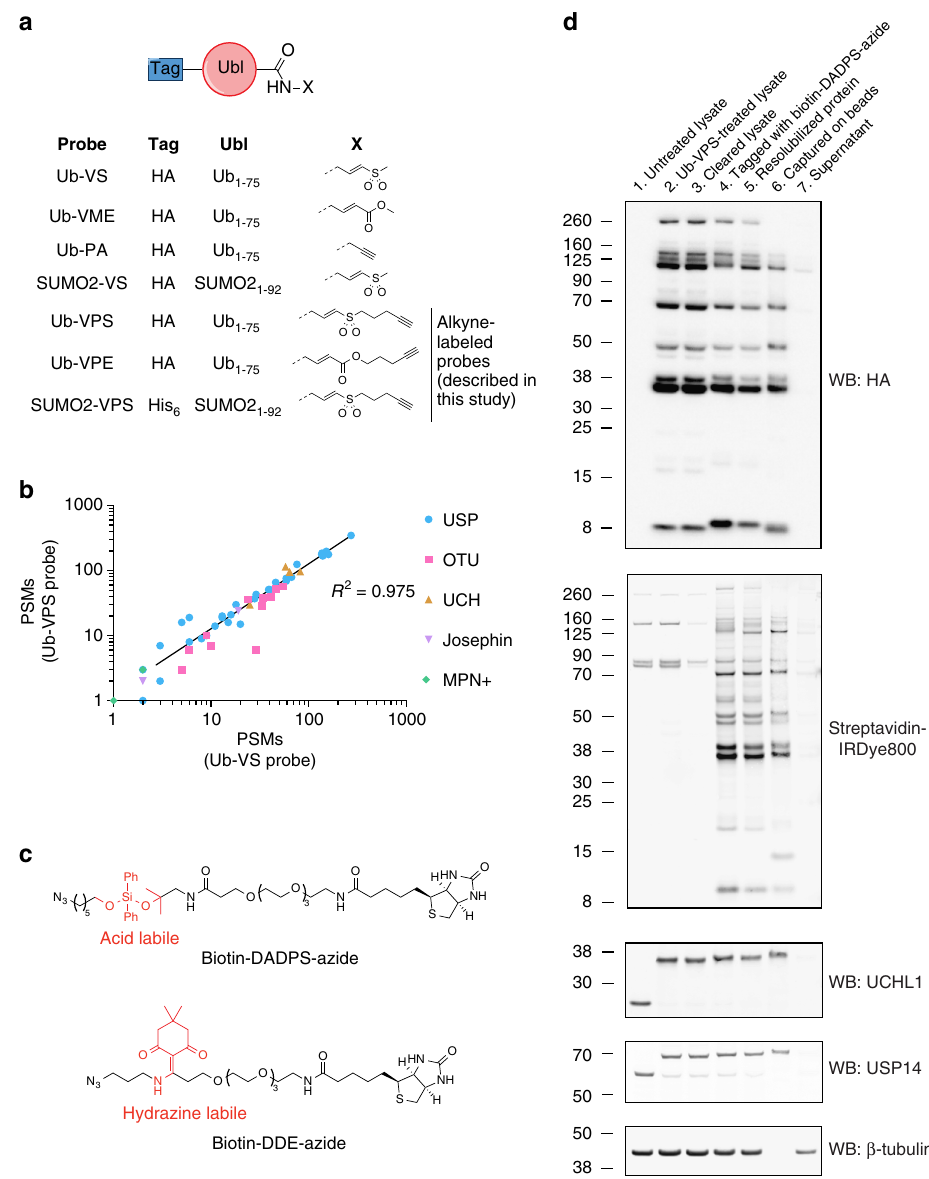
Fig. 2 Design and reactivity of alkyne-containing DUB probes. a Structures of probes used in this work. The vinyl pentynyl sulfone (VPS) and vinyl pentynyl ester (VPE) probes maintain the electrophilic groups of the commonly-used vinyl sulfone (VS) and vinyl methyl ester (VME) probes, and additionally contain an alkyne for attachment to biotin. Ubl, ubiquitin/ubiquitin-like protein. b Peptide-spectrum matches (PSMs) for DUBs detected following anti-HA IP, using either Ub-VS or Ub-VPS probes. Data are representative of two biological replicates. c Structures of linkers used in this work. d Western blottings (or streptavidin-biotin blotting) indicate the effectiveness of labeling with Ub-VPS, tagging with biotin-DADPS-azide, precipitation, and